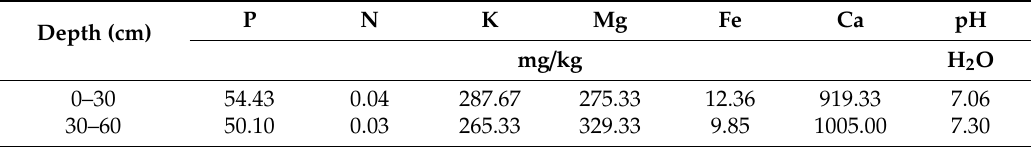
Table 1. Chemical characteristics of soils collected from the experimental